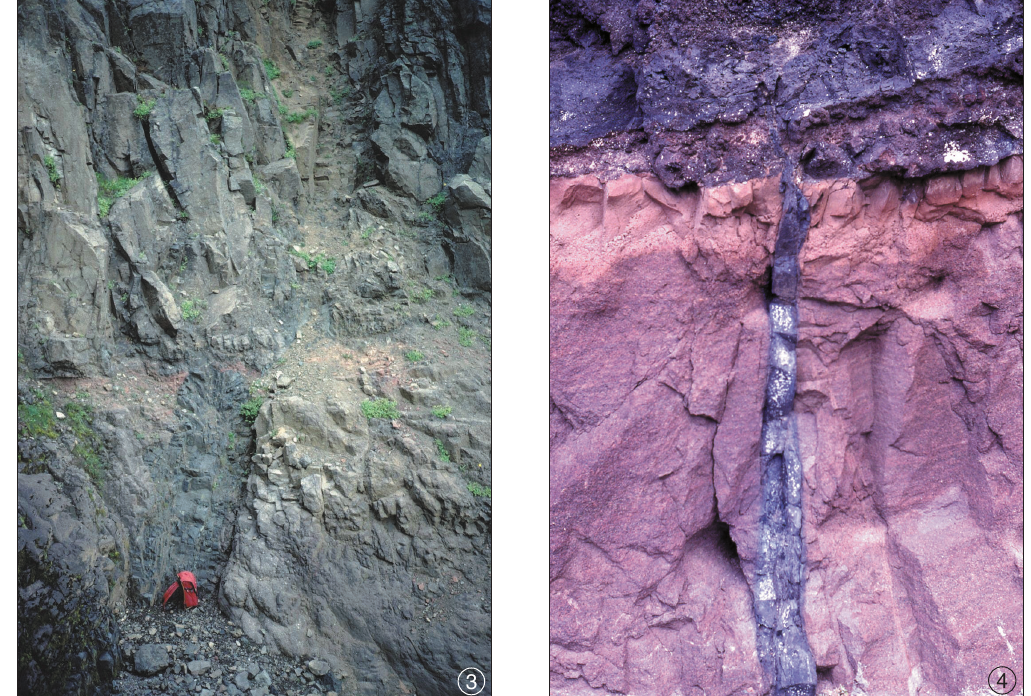
Fig. 3. Dyke becomes offset on crossing a weak scoria contact between two basaltic lava flows, of Tertiary age, in the palaeorift zone of North Iceland. View north, the dyke is around 1 m thick; the backpack at the lower dyke segment provides a scale. Fig. 4. Arrested tip of a basaltic dyke in a vertical exposure in the lava pile of Tenerife (Canary Islands). The dyke exposure is 3.7 m tall, strikes E-W, and dissects a baked pyroclastic rock layer in the lower part of the pho- tograph. The dyke is 0.26 m thick near the bottom of the exposure (at a road), and its thickness is similar up to near the contact between the pyroclastic rock and the basaltic lava flow (on top). There the dyke abruptly tapers away towards its tip. No dyke-induced joints or faults occur at the dyke